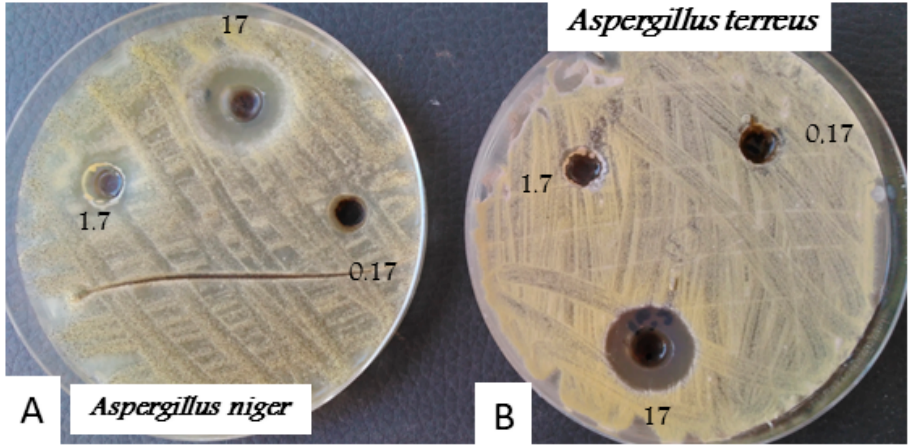
Figure 6. Aspergillus niger ( A ) and Aspergillus terreus ( B ) growth radial inhibition by the AgNPs. Values exhibited the AgNPs dilution expressed in µg/mL.